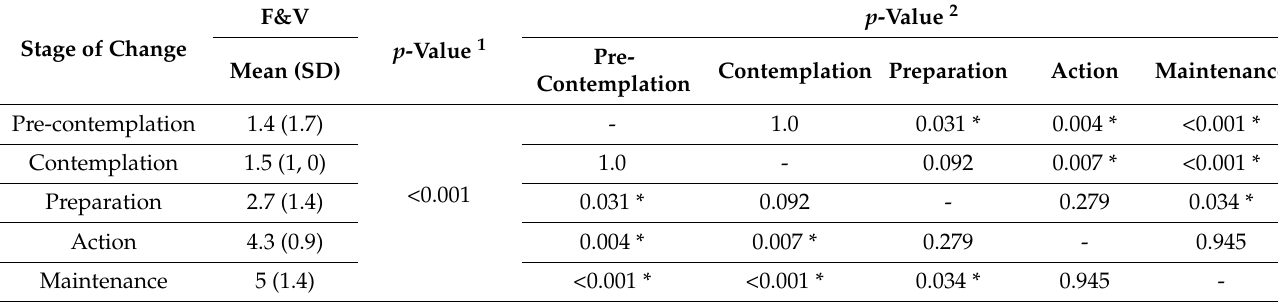
Figure 2. Daily intake of F&V according to stages of change. Table 3. Mean servings of F&V by stage of change.